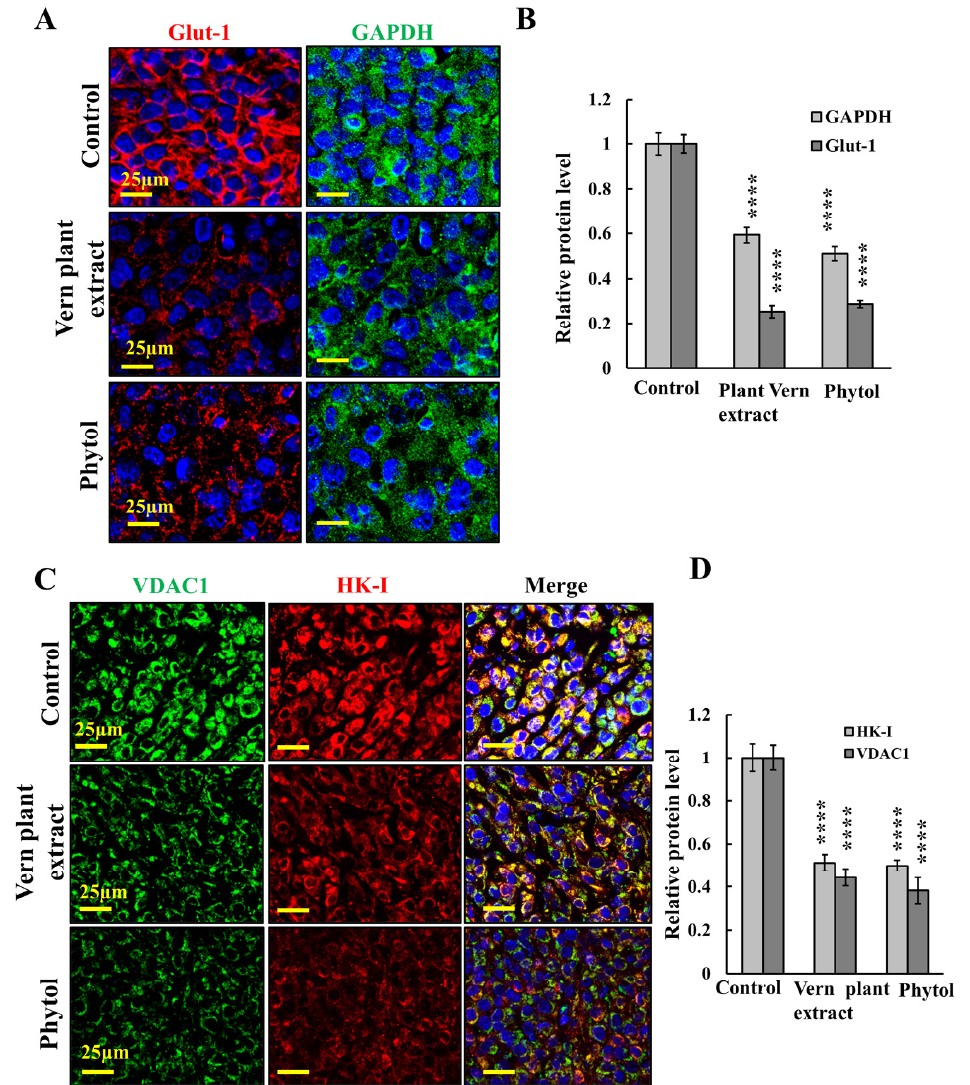
Figure 7. Tumor treatment with Vern plant extract or phytol resulted in reduced cell metabolism. (A – D) Confocal images of sections from U-87MG-derived tumors, control or treated with Vern plant extract (1:500) or phytol (75 μ M), immunofluorescent-stained for Glut-1 and GAPDH ( A,B ) or for VDAC1 and HK-I ( C , D ) using specific antibodies. Staining intensity was quantitative using Image J software ( B , D ). Results reflect the mean ± SEM ( n = 3), **** p ≤ 0.0001.